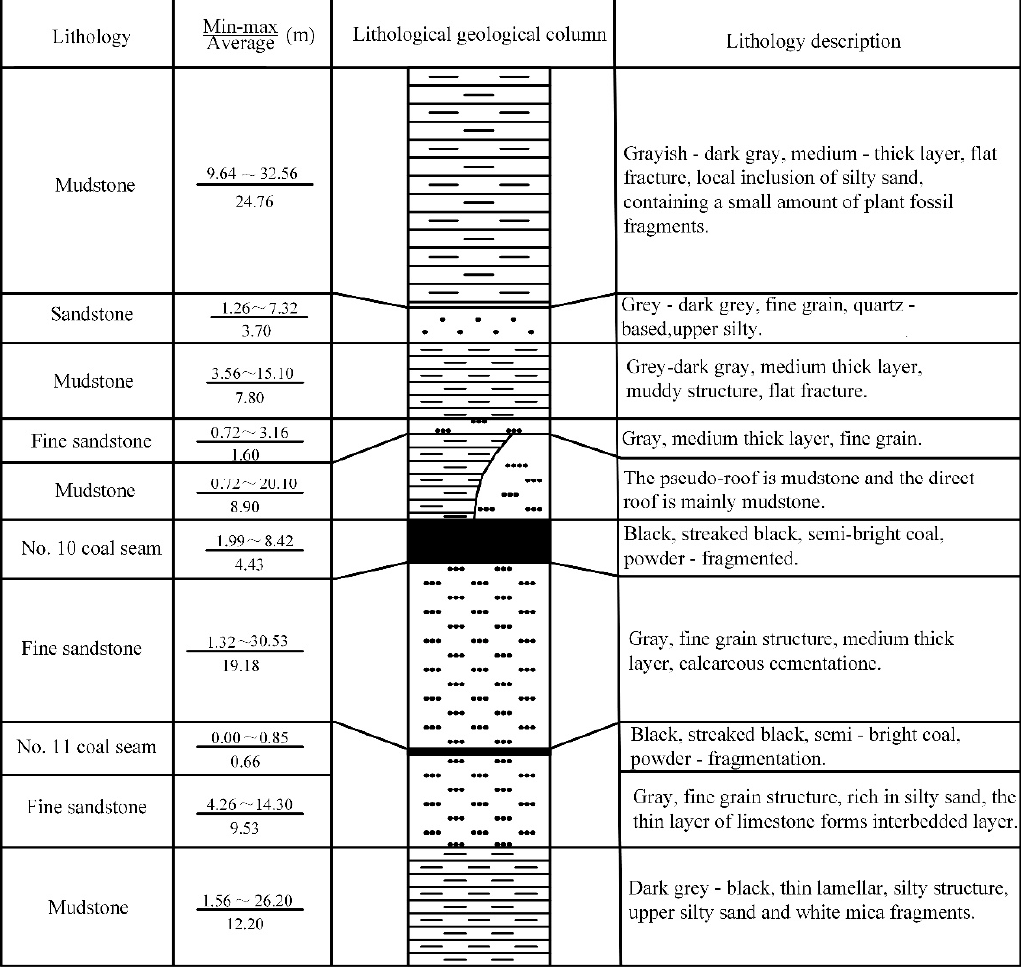
Figure 2. Stratigraphic columns of the 106 mining area.